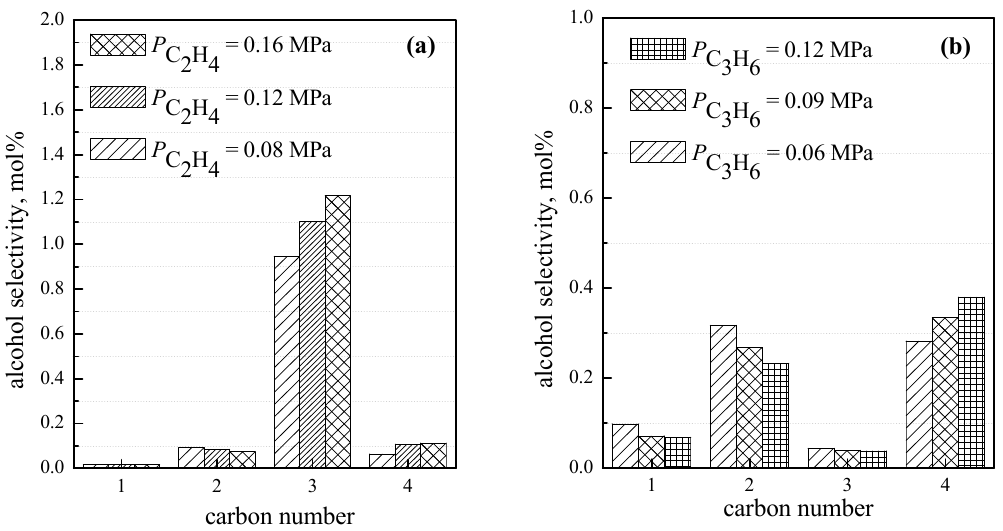
Figure 5. The alcohol selectivity with the increase in alkene partial pressure (T = 533 K, p = 0.8 Mpa, H 2 /CO = 12.0). ( a ) C 2 H 4 addition. ( b ) C 3 H 6 addition.